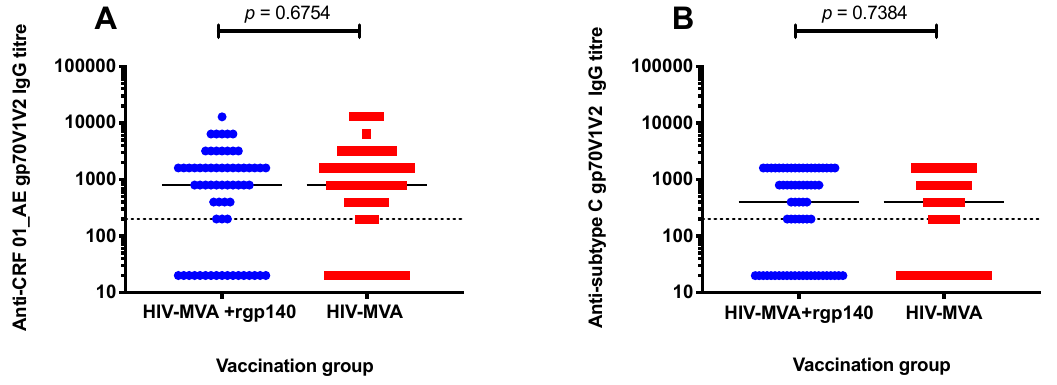
Figure 4. Vaccine-induced V1V2 IgG responses. Binding IgG responses to scaffolded gp70V1V2 protein of CRF01_AE ( A ) and subtype C ( B ) were determined in 144 vaccinees four weeks after the final immunization. Mann–Whitney test was used to compare the magnitude of anti-V1V2 IgG responses between the groups. No significant difference in the magnitude of binding IgG antibodies to V1V2 region of CRF01_AE and subtype C responses was observed between the two vaccination groups. The dotted line indicates the first dilution used. Results are reported as reciprocal values of end-point titers.